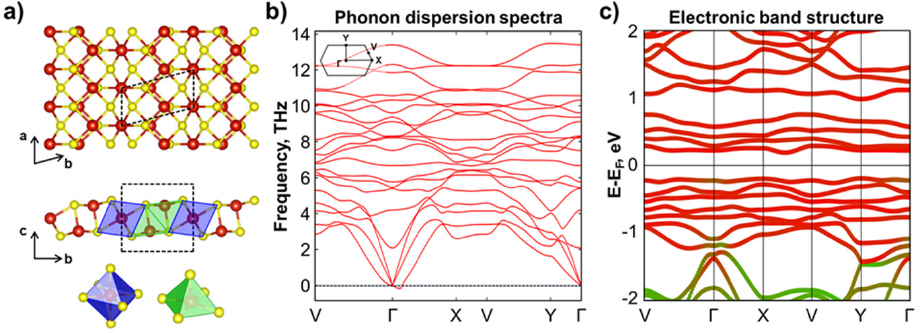
Figure 2. Newly predicted V 3 S 4 monolayer: ( a ) top and side views of the atomic structure (color legend: V—red; S—yellow); ( b ) phonon band structure; ( c ) electronic band structure of the most energetically favorable AFM configuration. The contributions from vanadium and sulfur atoms are indicated with red and green colors,